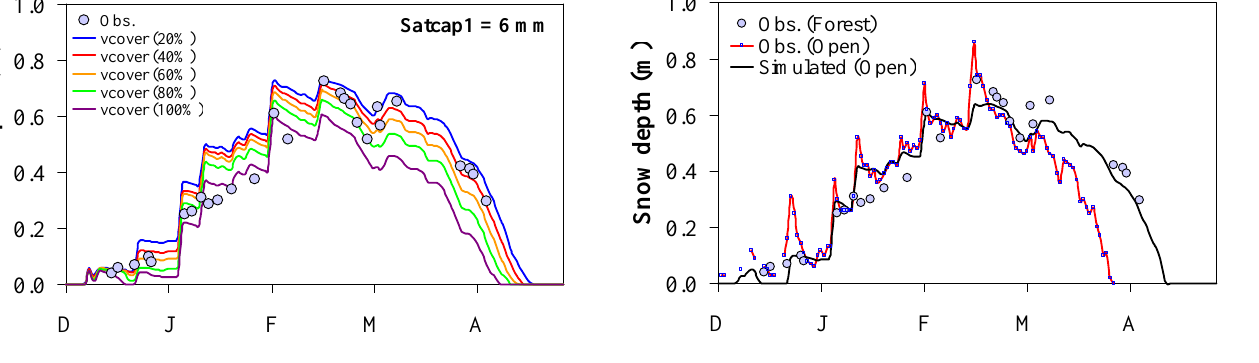
Fig. 10. The response of WEB-DHM-S simulated snow depth to different vegetation cover ( vcover ) at the HSG forest site.